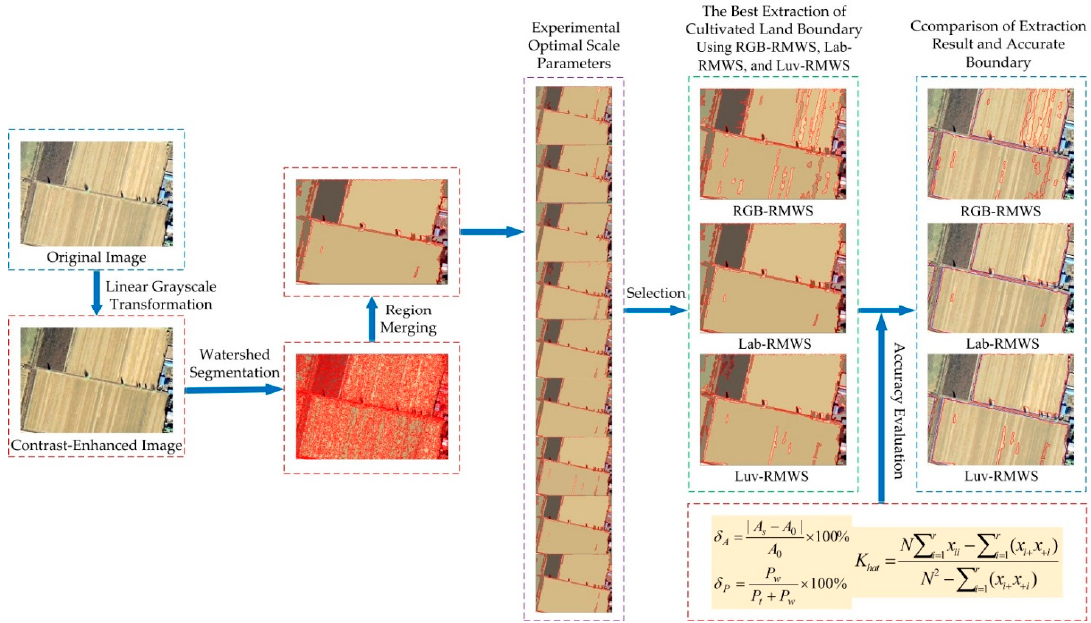
Figure 3. The flowchart of the improved method in this study.